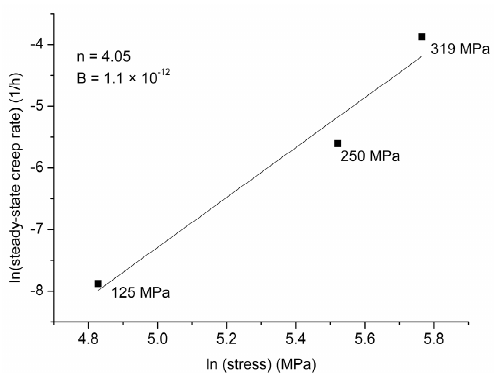
Figure 10. Steady-state creep rate dependence with the stress applied at 600 °C of the plasma-nitrided Ti-6Al-4V alloy.